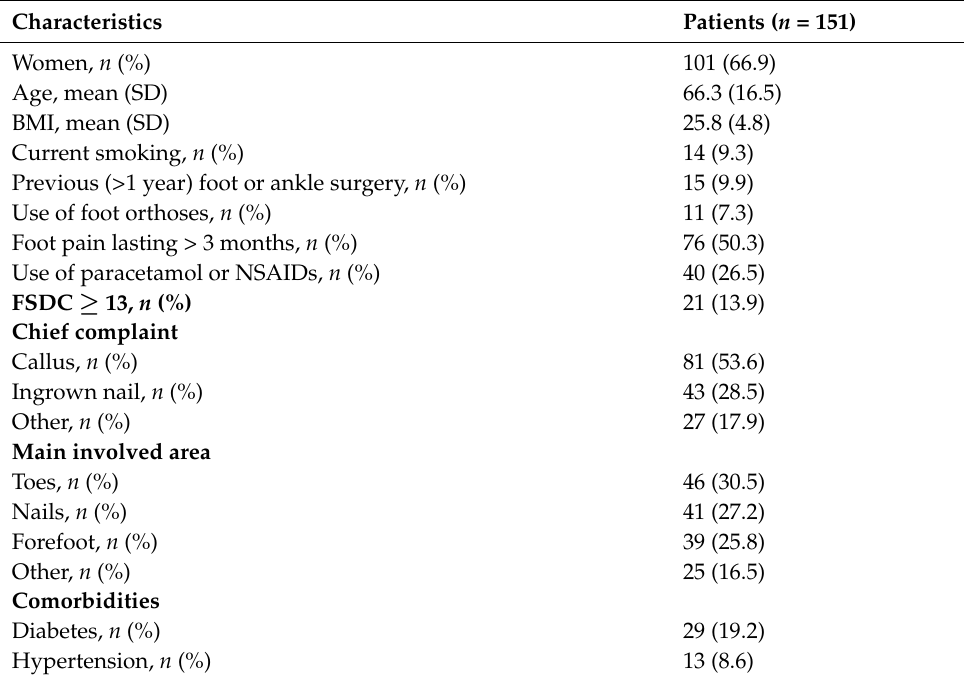
Table 1. General characteristics of the patients included in the